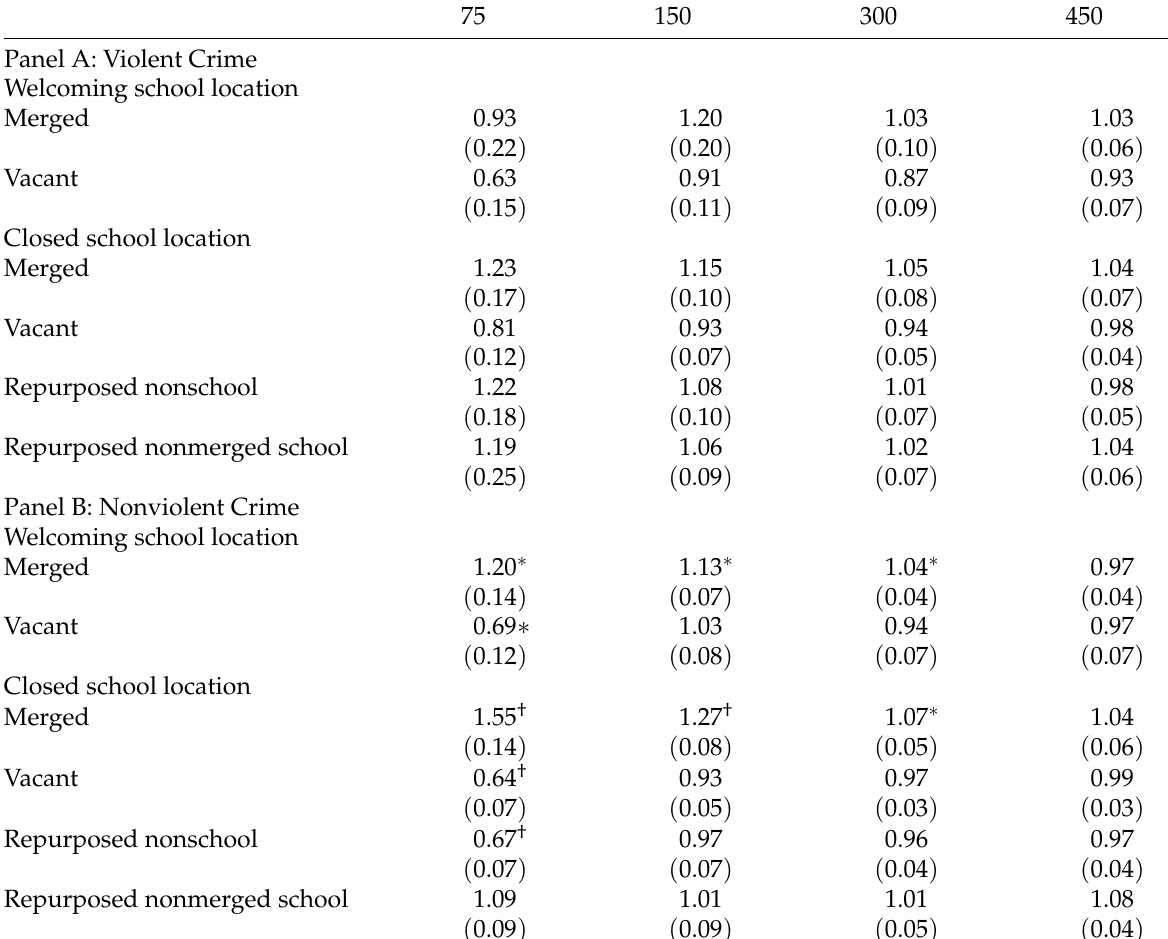
Table 6: Results from negative binomial regressions of violent and nonviolent crime counts on school closure condition by buffer radius and welcoming and closed school